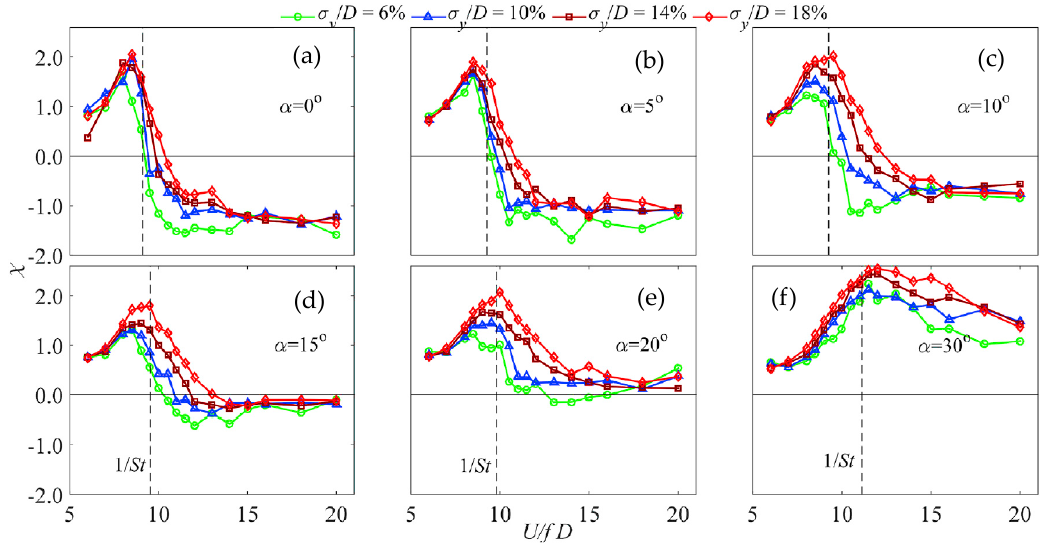
Figure 15. Generalized aerodynamic damping coefficients of forward inclined prisms [33]: ( a – f ) with respect to tip amplitude when the inclination angle is equal to 0°, 5°, 10°, 15°, 20° and 30°, respectively.